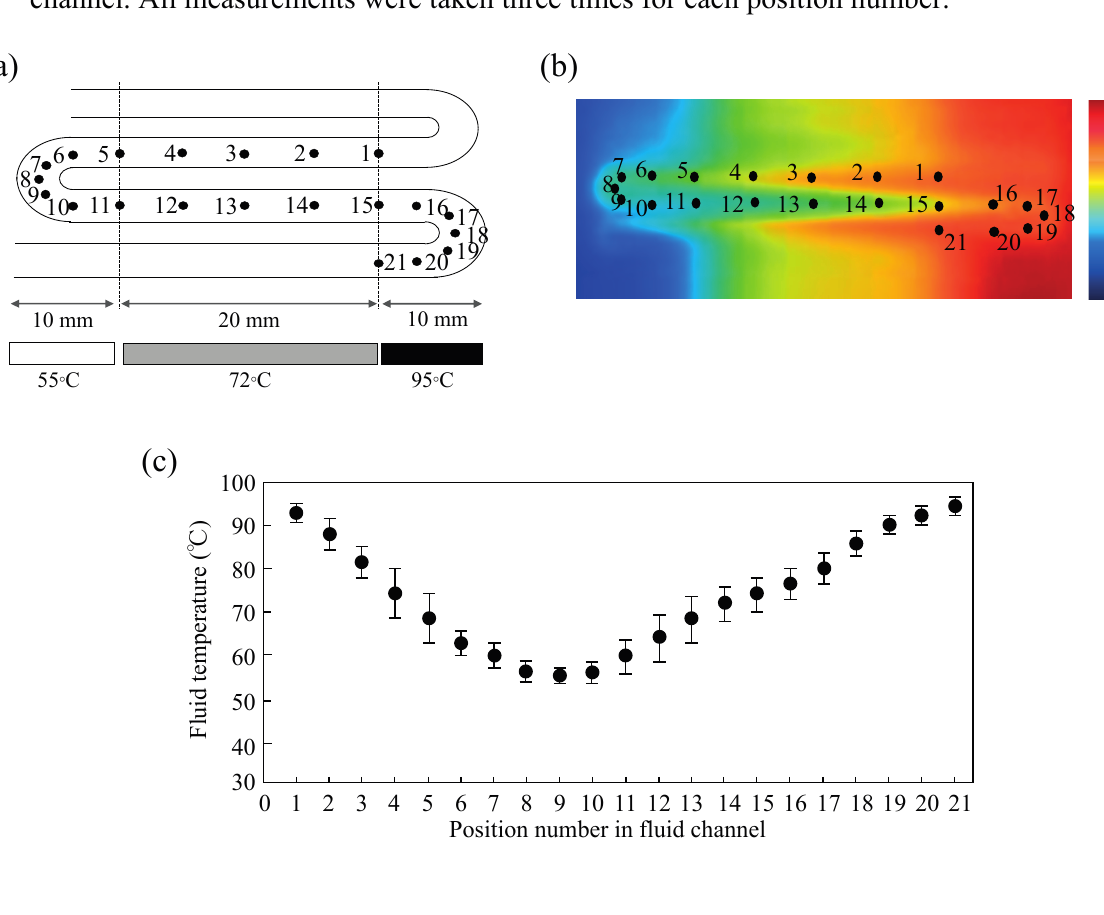
Figure 4. Temperature analysis at points marked on the PSA film and temperature distribution along the microchannel during flow: ( a ) Measuring points along the microchannel; ( b ) Measuring points for infrared imaging when the solution is flowing in the microchannel; ( c ) Fluid temperature distribution along the position number in fluid channel. All measurements were taken three times for each position